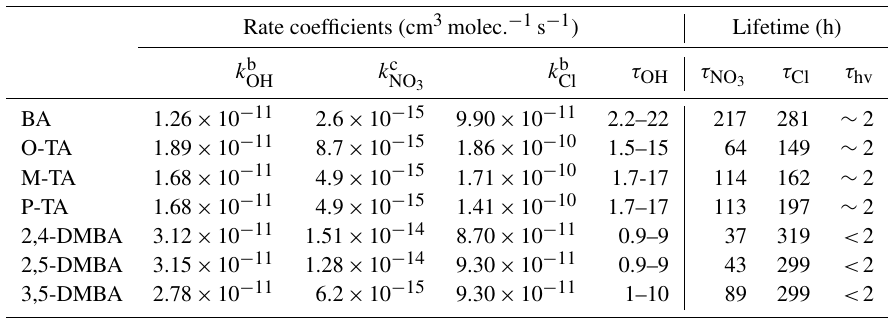
Figure 6. Pathways for the reaction between BA and NO 3 calculated using DLPNO-CCSD(T)/cc-pVTZ//BH&HLYP/6-311G(d,p). Enthalpic and Gibbs energy values are in kilojoules per mole (kJmol − 1 ). Key distances are in Ångströms (Å). Table 3. Summary of rate coefficients and estimated atmospheric lifetimes of benzaldehyde (BA), o -tolualdehyde (O-TA), m - tolualdehyde (M-TA), p -tolualdehyde (P-TA), 2,4-dimethylbenzaldehyde (2,4-DMBA), 2,5-dimethylbenzaldehyde (2,5-DMBA) and 3,5- dimethylbenzaldehyde (3,5-DMBA) with respect to their reactions with OH, NO 3 and Cl at 298 ± 2K and atmospheric pressure. a For comparison, the rough photolysis lifetimes are also noted for roughly 40 ◦ N during